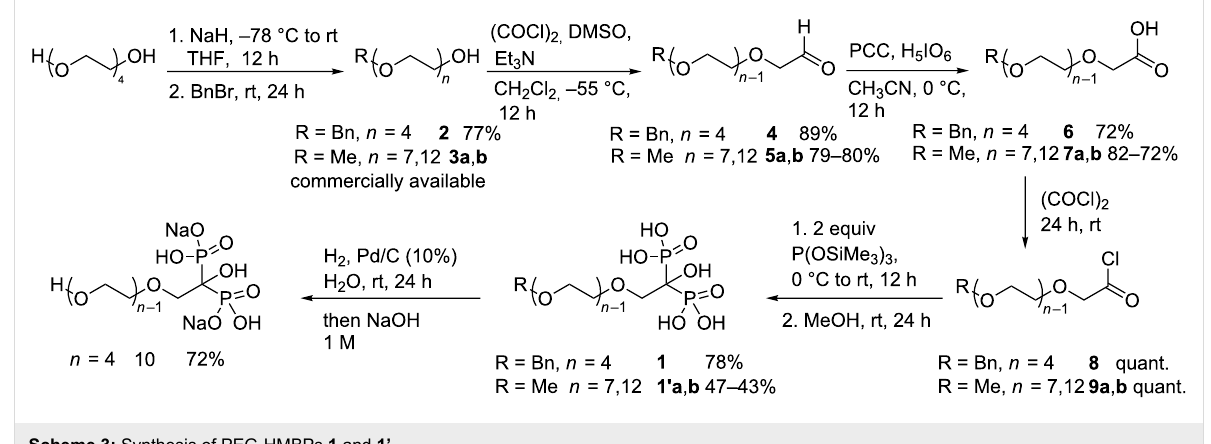
Scheme 3: Synthesis of PEG-HMBPs 1 and 1’ .